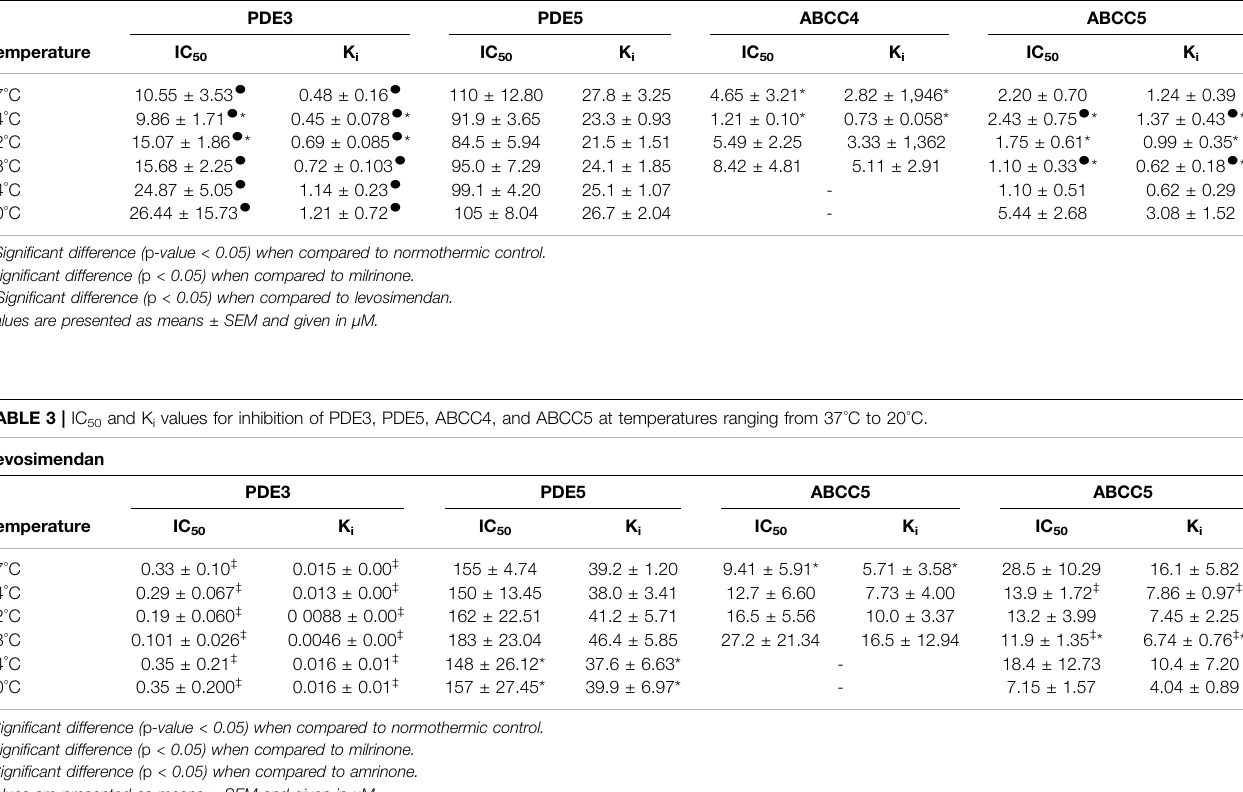
TABLE 2 | IC 50 and K i values for inhibition of PDE3, PDE5, ABCC4 and ABCC5 at temperatures ranging from 37 ° C to 20 ° C. Amrinone